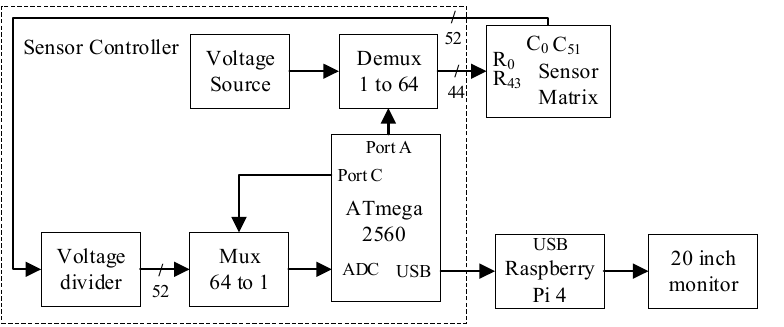
Figure 3. System block diagram (Reprinted with permission from Ref. [12] Copyright 2020 IEEE).